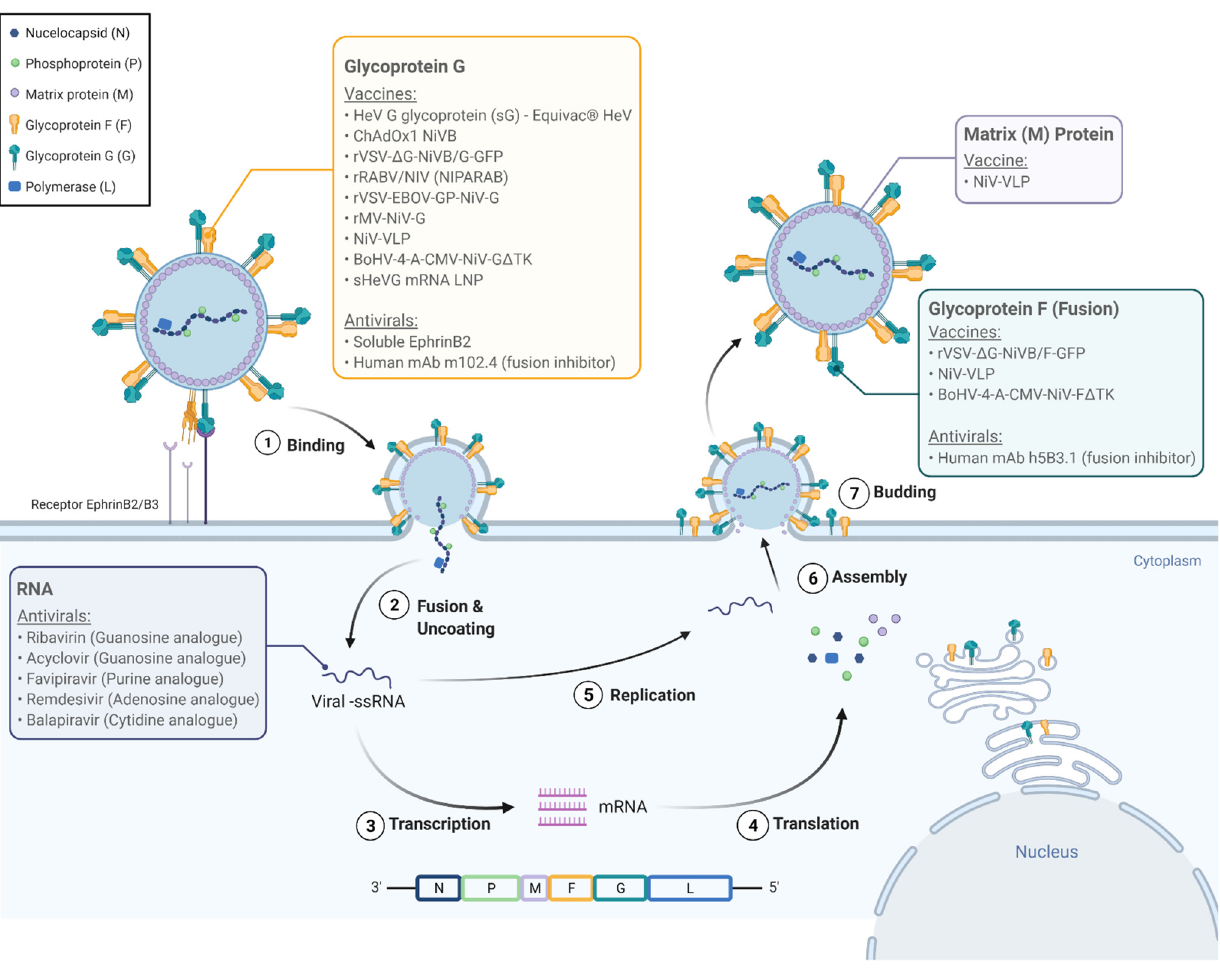
Figure 2. The Nipah virus life cycle and molecular targets for pharmacologic agents. Nipah virus attaches to the EphrinB2/B3 receptor (1) and enters the cell (2). The viral genome is released and is replicated, as well as transcribed into viral messenger RNA, which are in turn translated into viral proteins N (nucleocapsid), P (phosphoprotein), M (matrix protein), G (glycoprotein G), F (glycoprotein F/fusion protein), and L (polymerase). The new viral genome and proteins are assembled, encapsidated, and released from the cell (7). The colored labels highlight the molecular targets for the vaccines and antivirals listed in Tables 2 and 3.